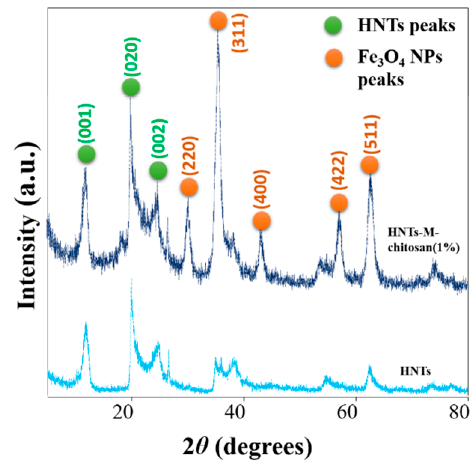
Figure 4. XRD analysis of HNTs and HNTs-M-chitosan (1%).